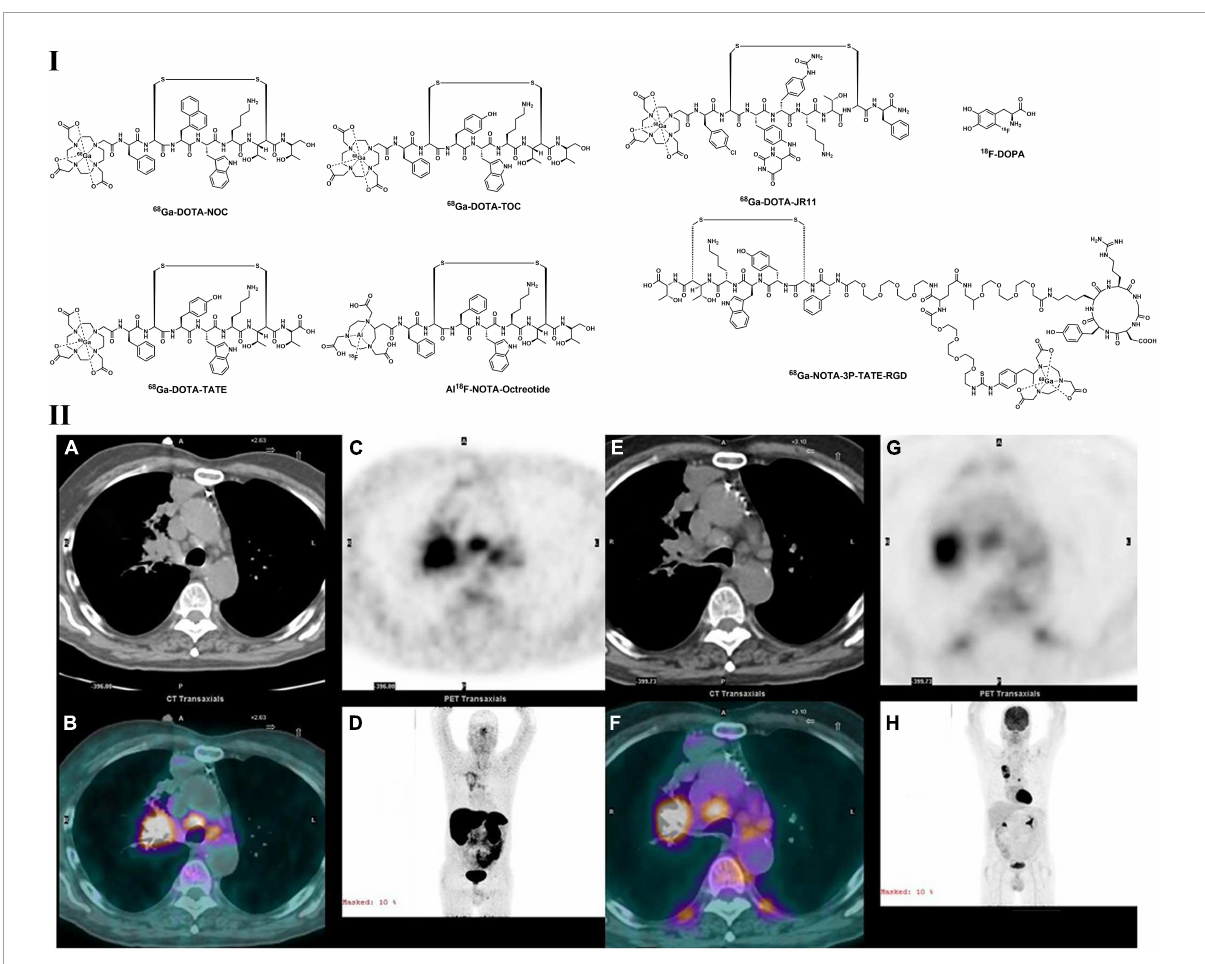
FIGURE4 Structures of representative PET tracers for pulmonary NETs (I) and PET images of 68 Ga-DOTATATE (A–D) and 18 F-FDG (E–H) in patient with squamous cell carcinoma (II) . Concordant radioactivity accumulation can be observed in mediastinal adenopathy, right hilum and right upper lobe